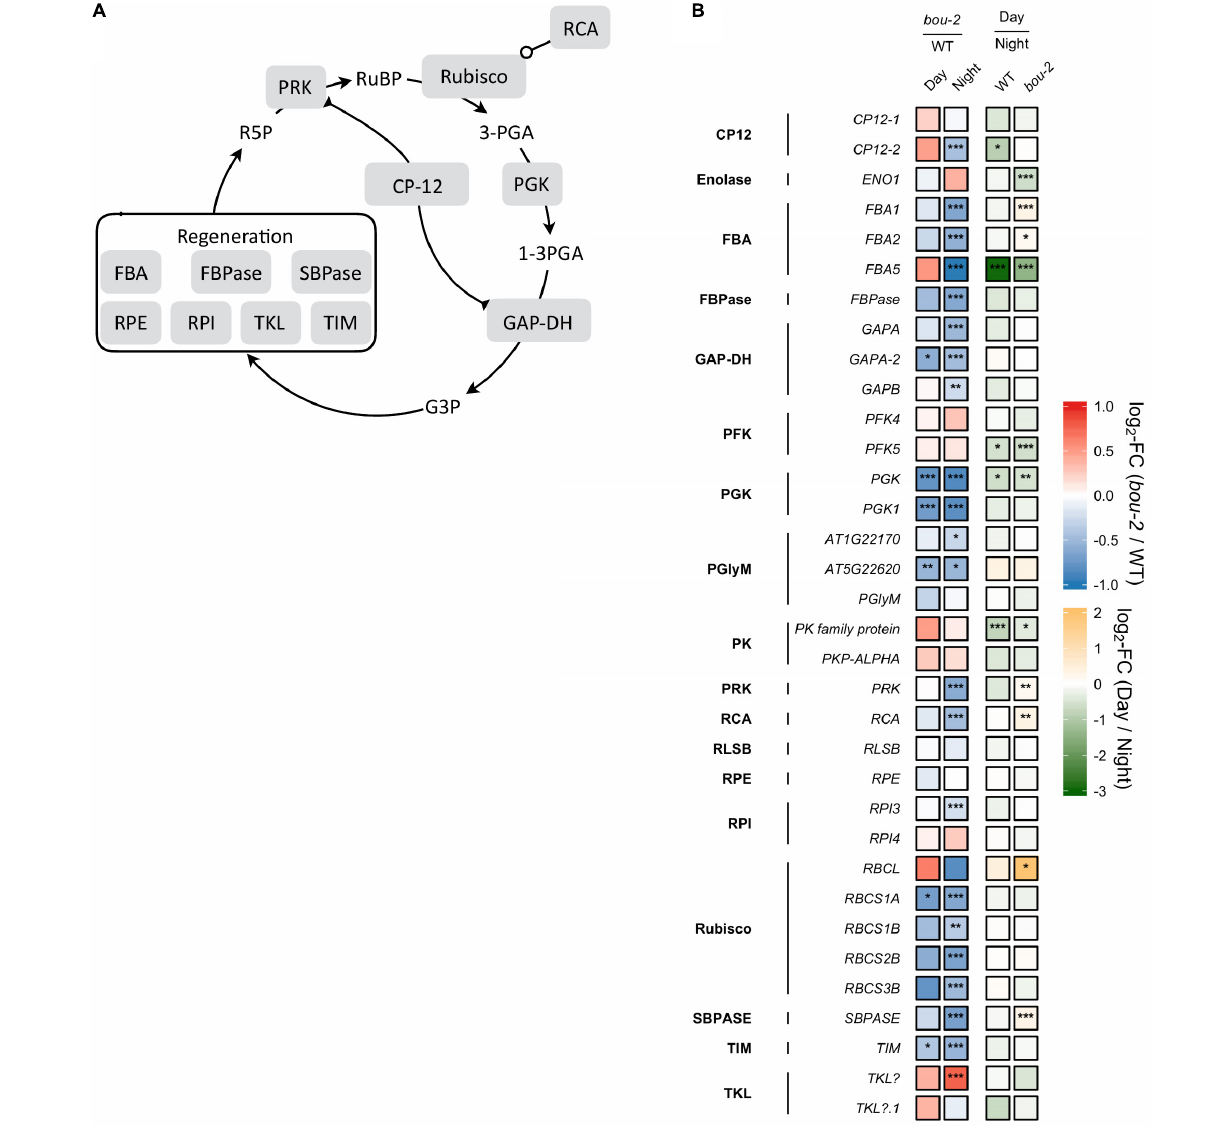
FIGURE 4 | (A) Schematic presentation of the Calvin–Benson–Bassham cycle (CBBC). (B) Transcript levels ( n = 3) of genes involved in CBBC. Left two tiles of each gene represent the log2-fold change (FC) between the bou-2 mutant and WT plants under both day (D) and night (N) with false color code ranging from red (higher in bou-2 ) to blue (higher in WT). Right two tiles represent the log2-fold change (FC) between day and night within WT plants and bou-2 mutant with false color code ranging from green (higher at night) to yellow (higher at day). Asterisks indicate differential gene expression as determined by Sleuth ( ∗ FDR < 0.05, ∗∗ FDR < 0.01, and ∗∗∗ FDR < 0.001). CP12, CP12 domain-containing protein; FBPase, fructose bisphosphatase; GAP-DH, glyceraldehyde 3-phosphate dehydrogenase; PGK, phosphoglycerate kinase; PRK, phosphoribulokinase; RCA, rubisco activase; RPE, ribulose-phosphate 3-epimerase; RPI, ribose-5-phosphate isomerase; Rubisco, ribulose-bisphosphate carboxylase; SBPASE, sedoheptulose-1,7-bisphosphatase; TKL,